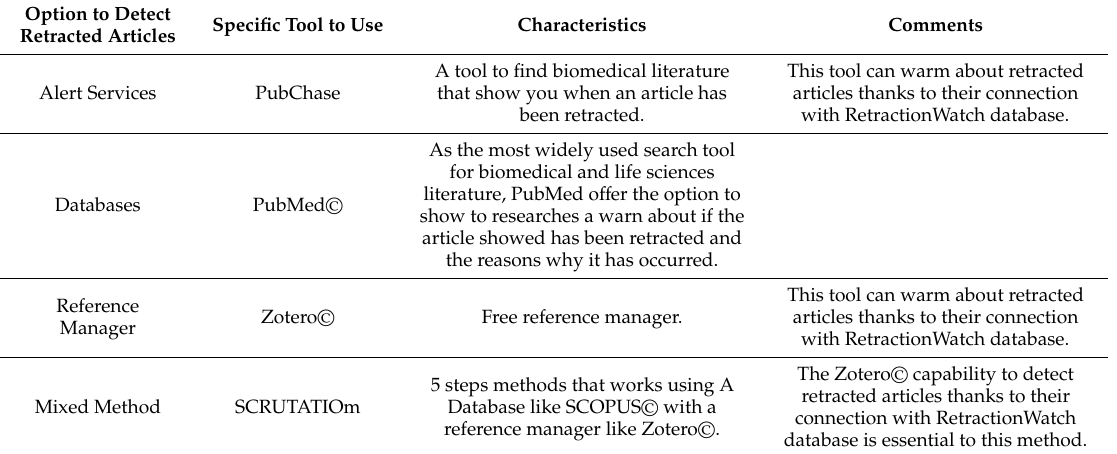
Table 1. Characteristics of some elements included in four options described as useful to detect retracted